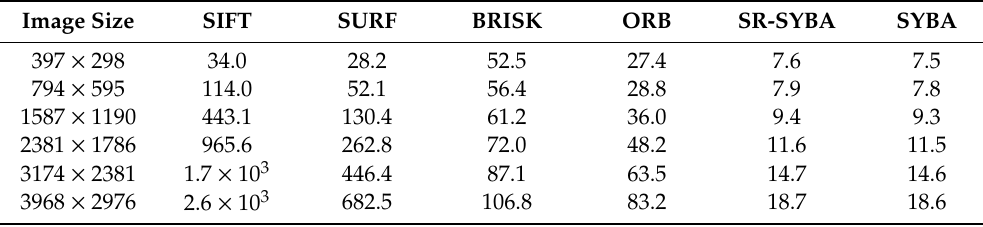
Table 3. The memory usage (MB) of each algorithm at runtime. Image Size SIFT SURF BRISK ORB